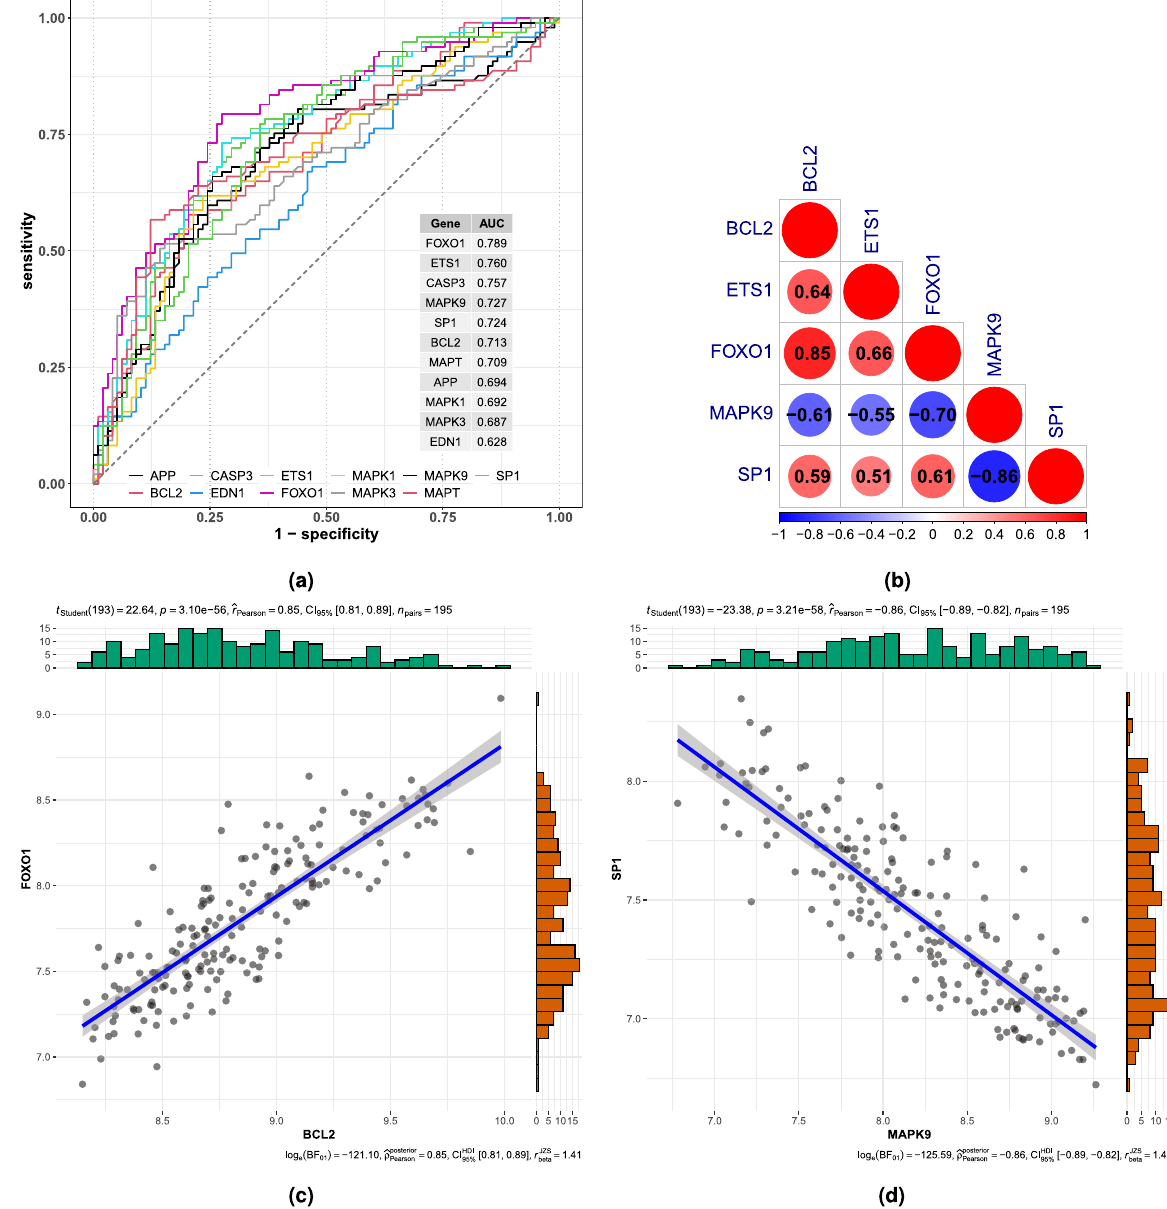
Figure 13. ( a ) ROC curve analysis of candidate hub genes. The seven with best performance for distinguishing AD from control samples according to area under the curve (AUC) were selected for further analyses. ( b ) Correlations between expression levels of various candidate hub gene pairs. ( c ) Correlation between FOXO1 and BCL2 expression. ( d ) Correlation between SP1 and MAPK9